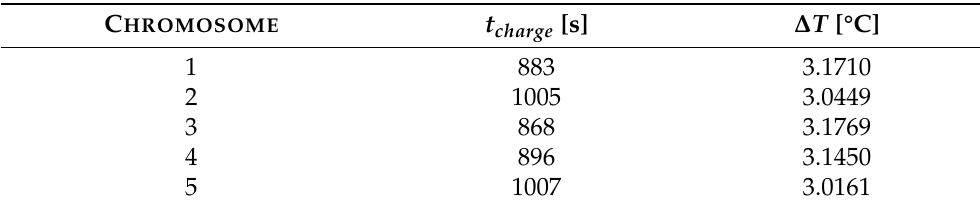
Table 6. The attributes of the initial population. This pool is the jumping-off place of the entire